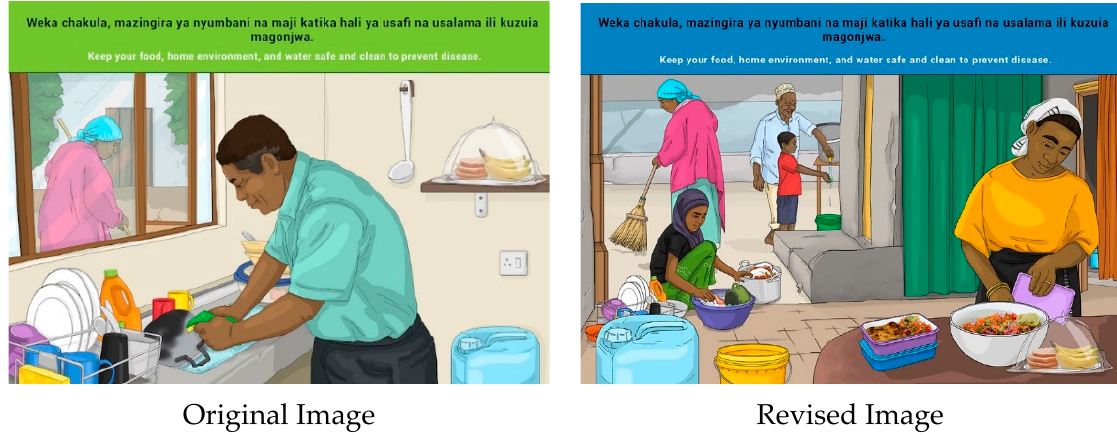
Figure 16. Keep your food, home environment and water safe and clean to prevent diseases.